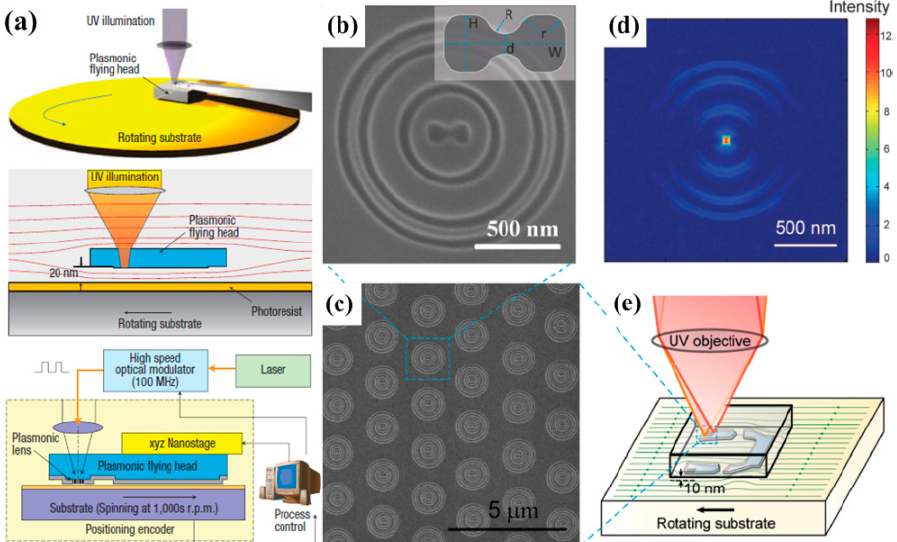
Figure 8. ( a ) Schematic of the maskless nanolithography concept using a flying lens. ( b ) Magnified SEM and ( c ) overview of the plasmonic lens structure. ( d ) Calculated intensity distribution at 10 nm distance away from the lens with 355 nm incident wavelength. ( e ) Schematic of the plasmonic flying head using advanced airbearing surface. Reproduced with permission from [129] and [130]. Copyright Springer Nature, 2008 and